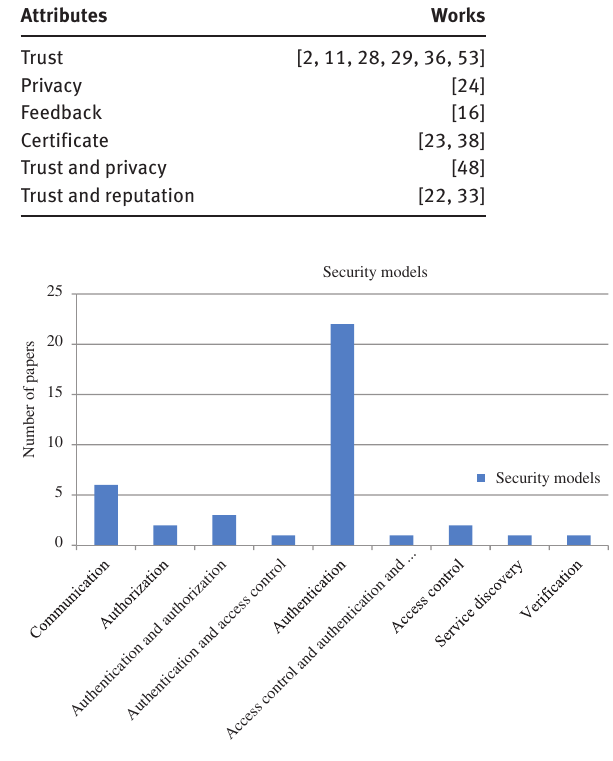
Figure 2: Bar Chart Based on the Security